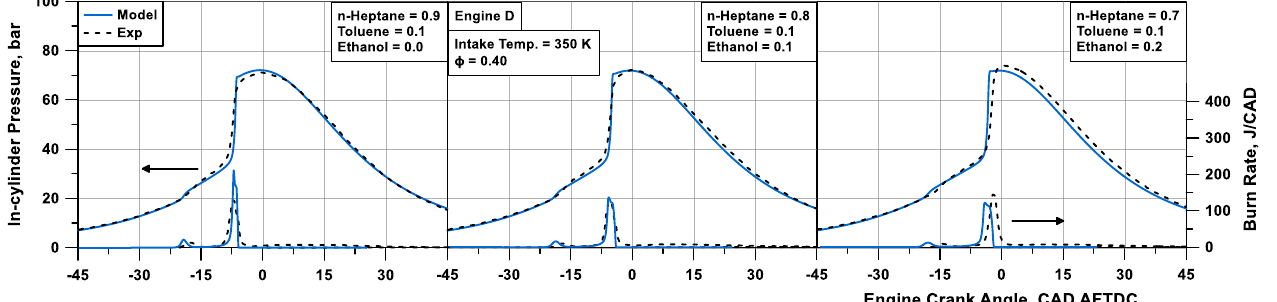
Figure 13. Numerical/experimental comparison of in-cylinder pressure traces and heat release rate profiles for Engine D ( y m sweep).